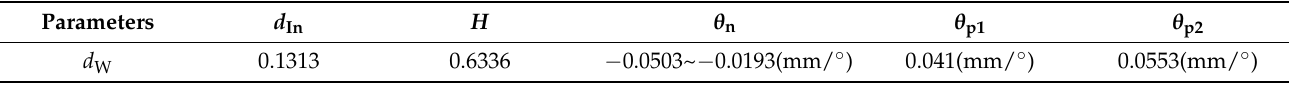
Table 2. Sensitivity of d W to each